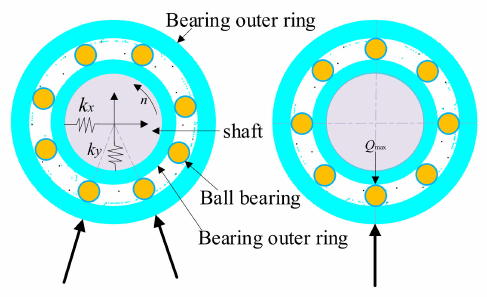
Figure 20. Bearing unit.